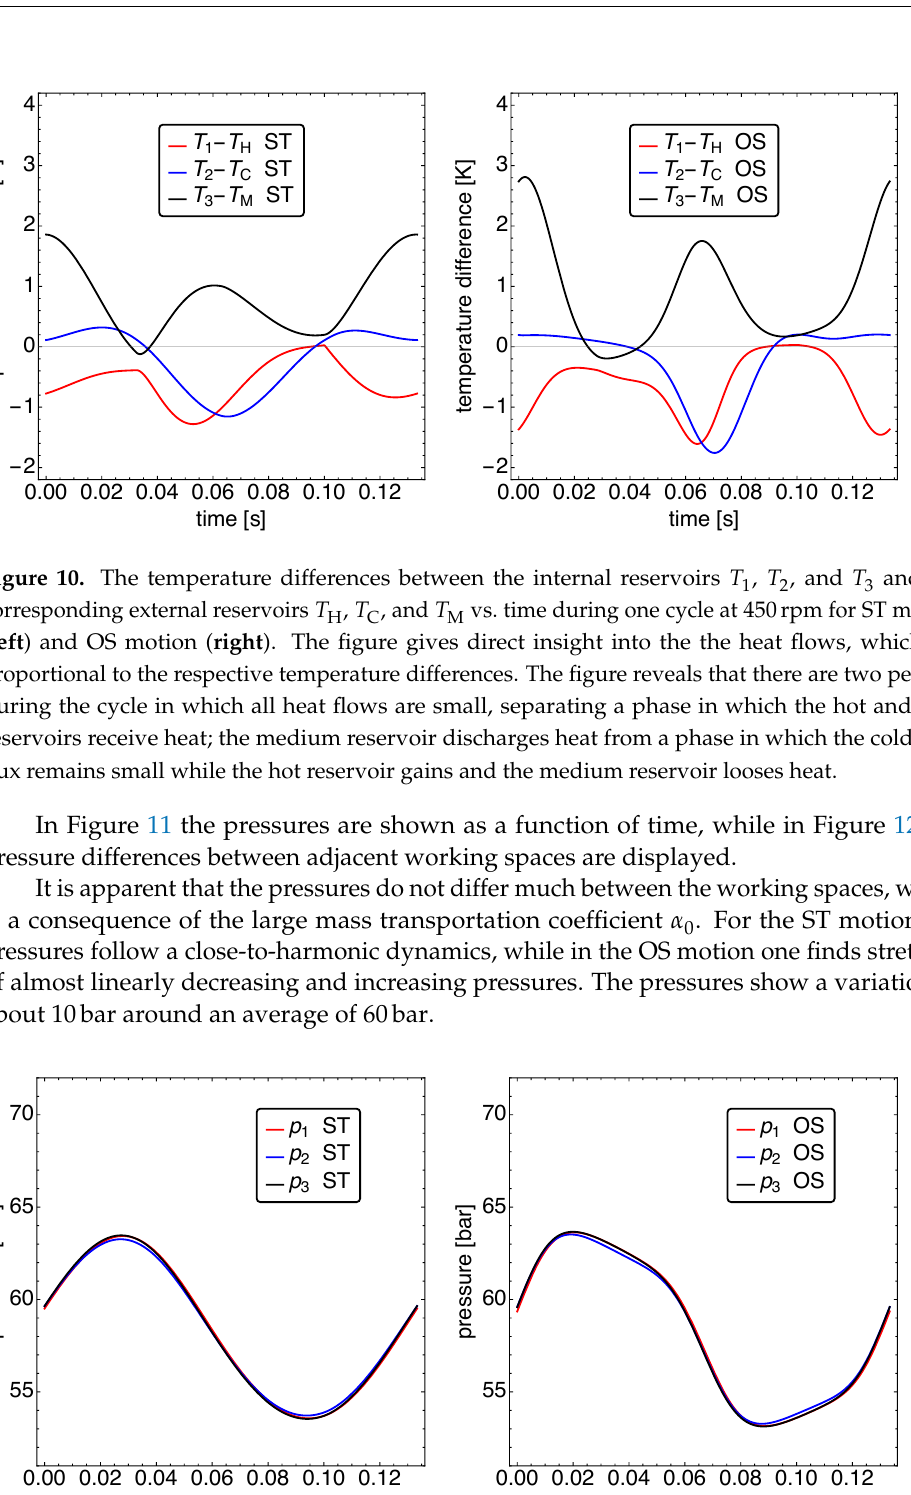
p p Figure 11. The pressures p 1 , 2 , and 3 of the three reservoirs vs. time during one cycle at 450rpm for ST motion ( left ) and OS motion ( right ). In general, the pressure differences between the reservoirs are small compared to the absolute pressure values. We note the distortion of the pressure trajectories for the OS motion due to the more square-like motion of the hot